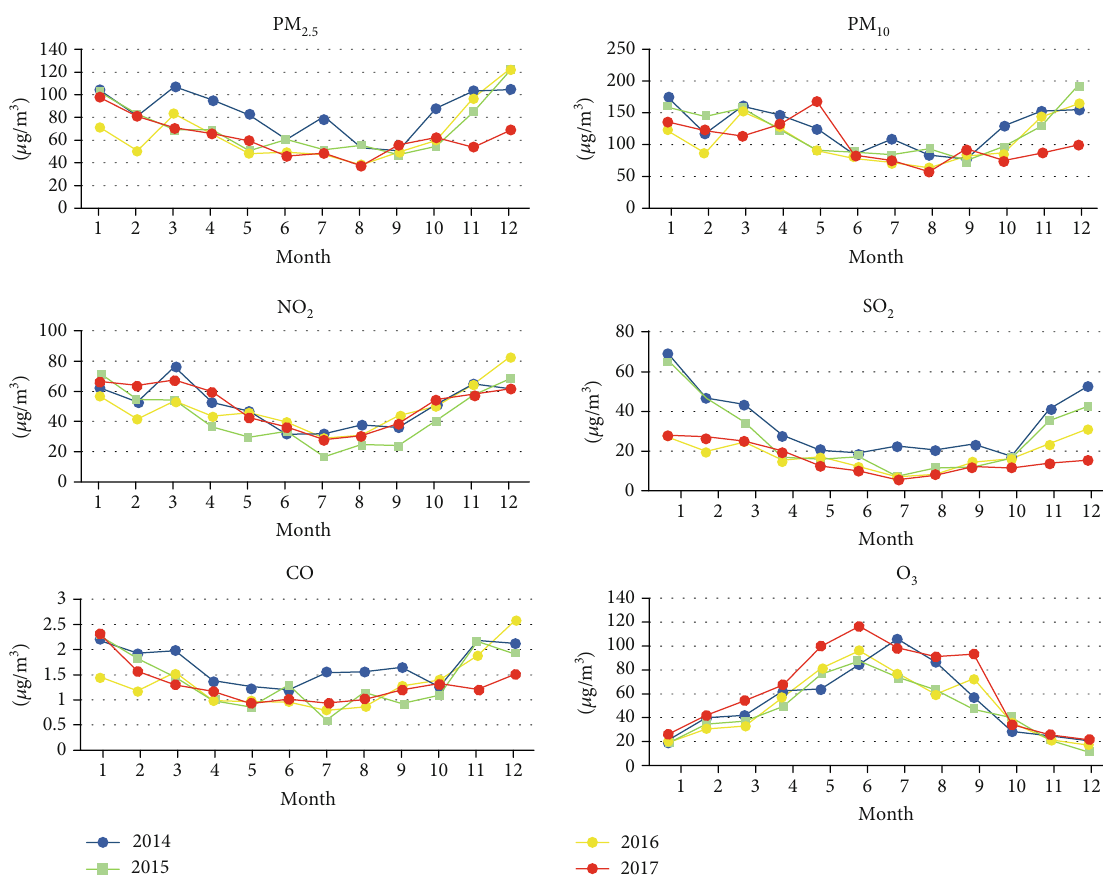
Figure 2: Monthly average changes in air pollutants for show the impact of di ff erent meteorological factor values on the incidence of diabetes when lagging on di ff erent days. depicting the estimated e ff ects on diabetes incidence of the full range of meteorological factors over di ff erent lag days (refer- enced to the lowest e ff ect value of meteorological factors). It is similar to the plot in Figure 6 and describes the risk of diabe- tes incidence with color. Blue indicates that the RR value was < 1, and red indicates an RR value of > 1. In other words, blue indicates a protective factor, and red indicates a risk factor, and the darker the red color, the higher the risk of diabetes.